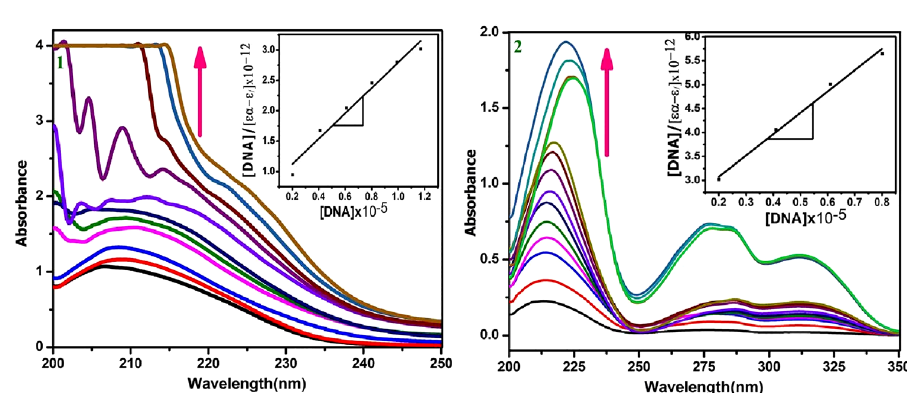
Figure 4. Electronic absorption spectra of molecule 1 and 2 are in the absence and presence of increasing amounts of CT-DNA (25µL—350µL). Arrow shows the increase absorbance with increase the DNA concentration. Inset: plot of [DNA]/ (εa-εf) Vs [DNA].